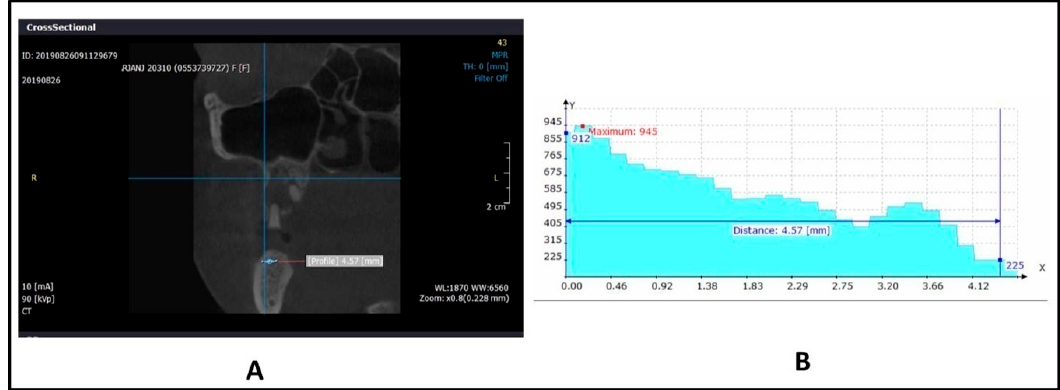
Figure 1. ( A ): Measurement of grayscale (GS) values using cone beam computed tomography (CBCT) technique in maxilla. ( B ): Graphical representation of corresponding GS value (HU).